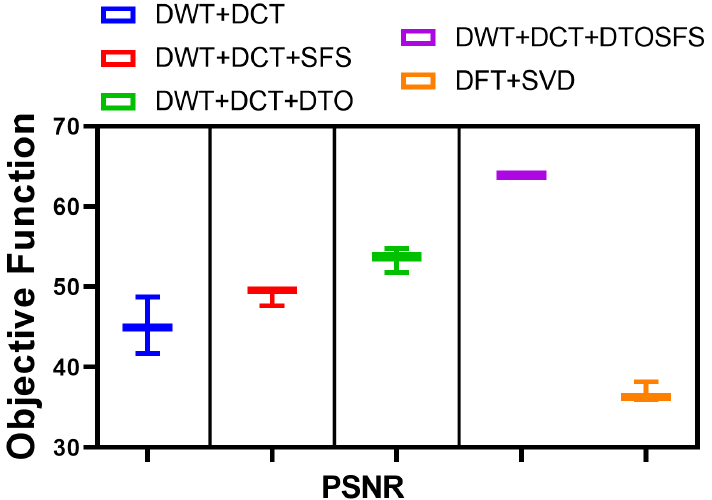
Figure 11. The PSNR values achieved by the proposed approach in comparison with the other